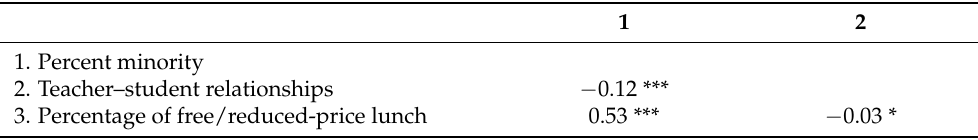
Table 4. Pearson correlations between school-level fixed